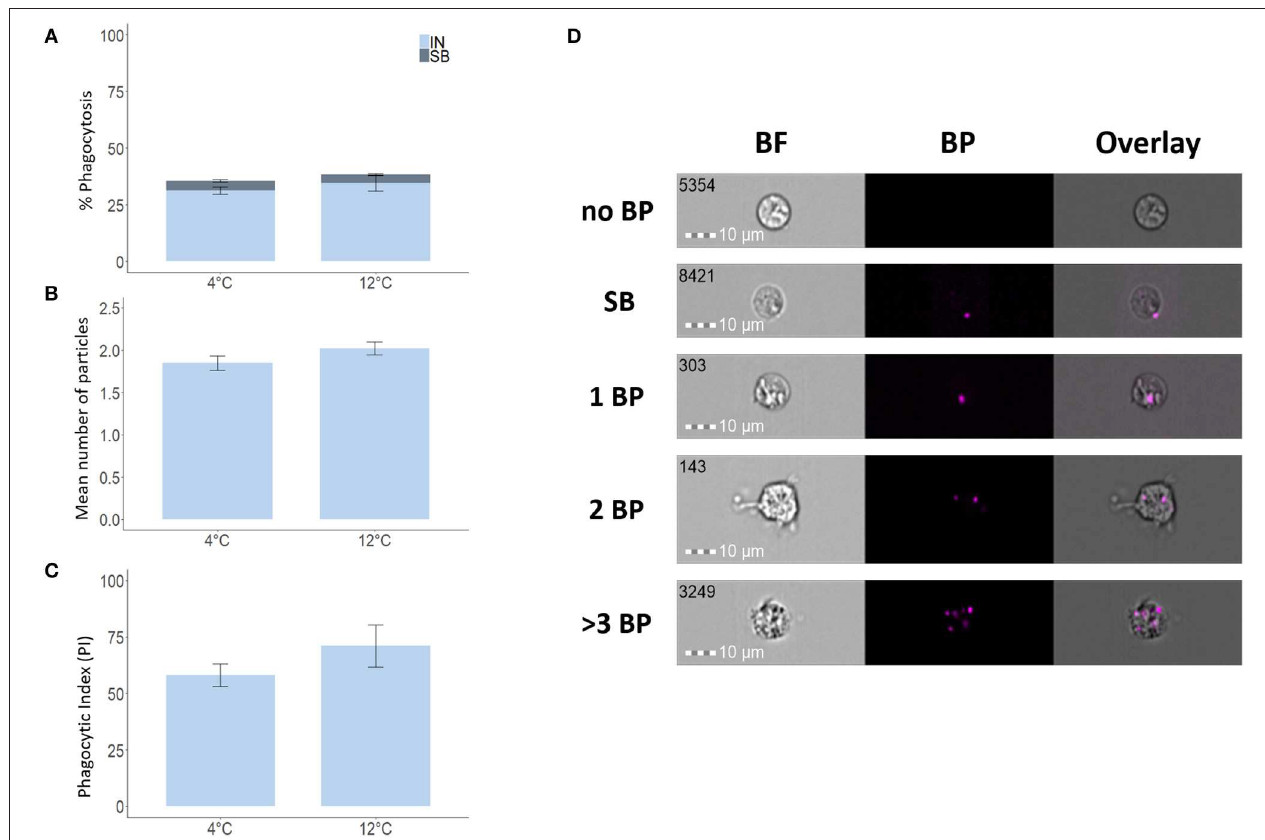
FIGURE 7 | Phagocytosis of blue mussel hemocytes incubated at different temperatures. Percent of phagocytic cells (A) , mean of number of particles ingested per phagocytic cell (B), and phagocytic index, PI (C) . Representative cell images that show cells with no BP, SB, and 1BP, 2BP, and > 3BP (D) . Statistically significant differences ( p < 0.05) are indicated using asterisks. Bar plots show the mean ± SD. Sample size = 6. All cell images were captured with 40 × objective. Scale bar = 10 µ m. IN, internalization; SB, surface-binding particles; 1 BP, 2 BP, and > 3 BP, 1–3 internalized bio-particles; BF,